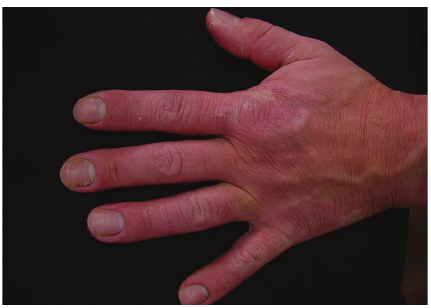
Figure 2: Hand eczema and paronychia (Case 2).